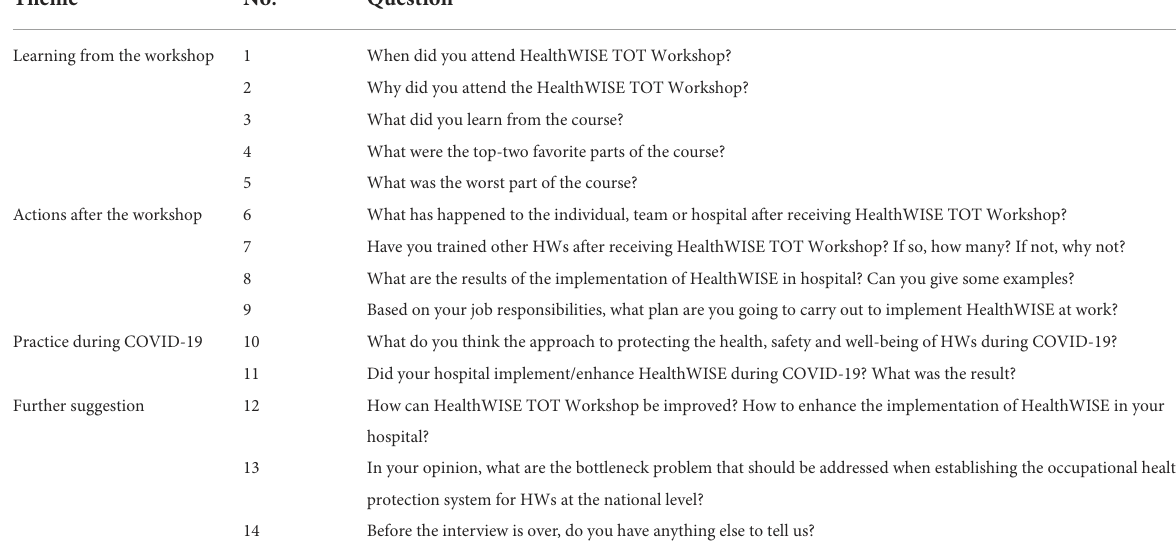
TABLE 1 Interview questions about the application of